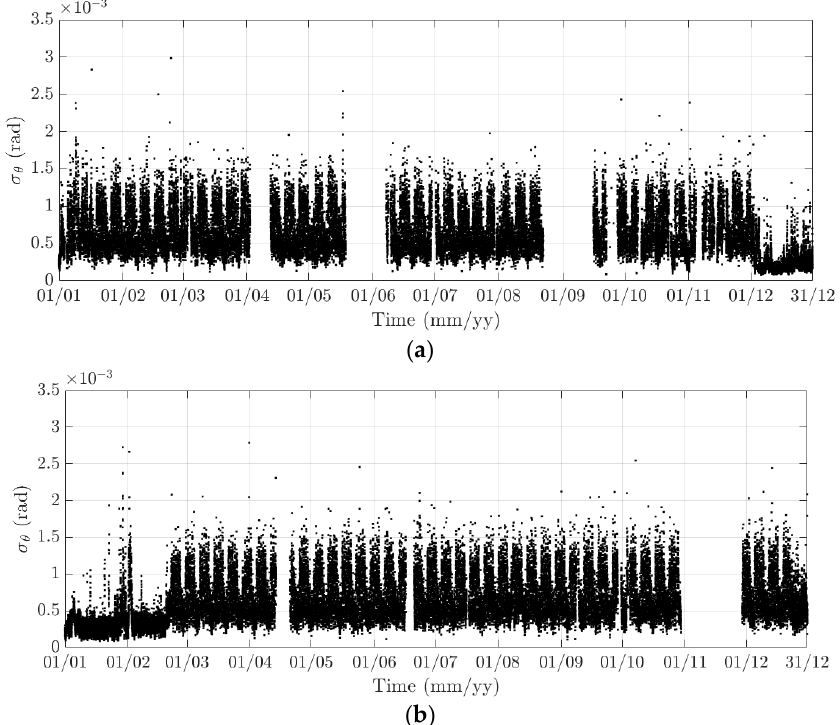
Figure 17. Variation of the 10 ‐ min standard deviation of the torsional response at the mid span of the FRB in ( a ) 2015 and ( b ) 2016.